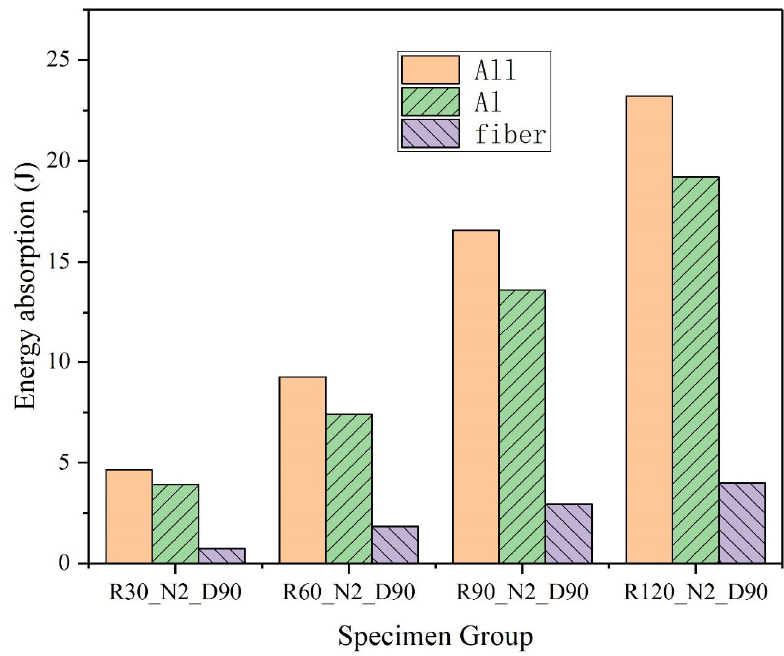
Figure 16. Global energy distribution.